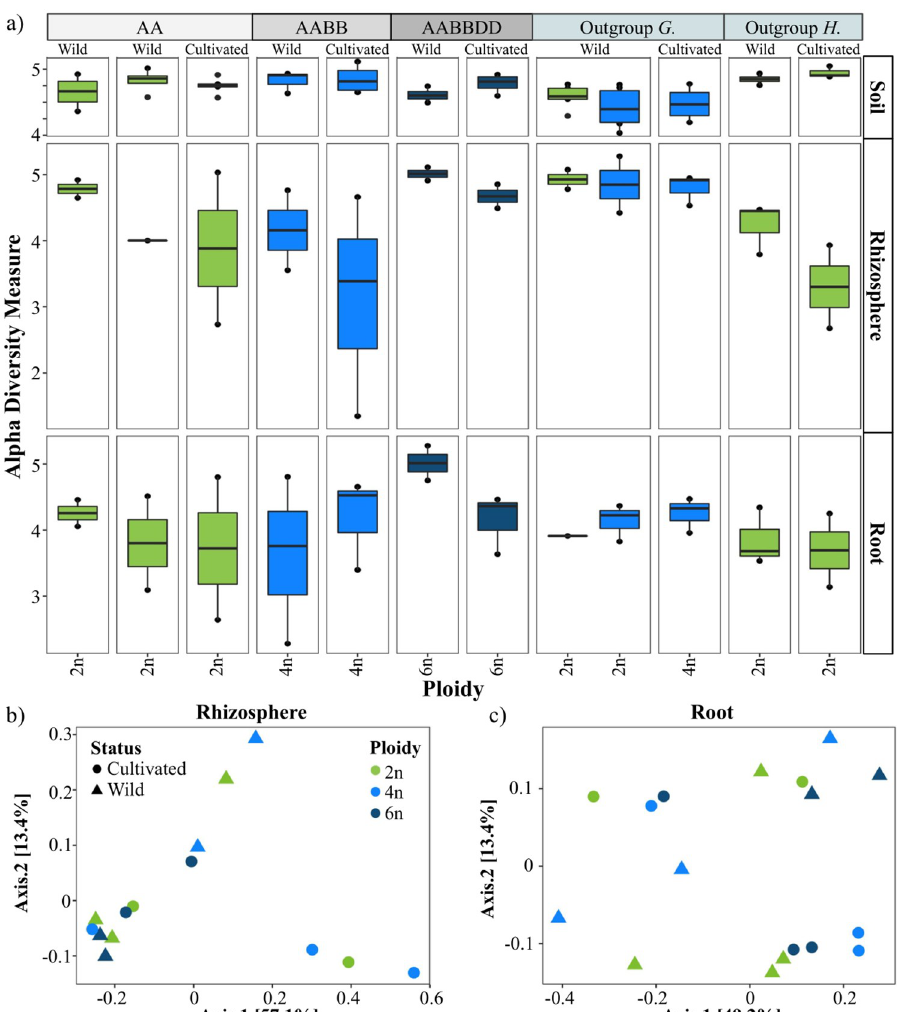
Fig 3. Alpha diversity shifts with ploidy level and domestication status. Alpha and beta diversity analyses of greenhouse study data, presented as boxplots of Shannon Diversity (a) and principal coordinates analyses using Bray- Cutis dissimilarity of wheat rhizosphere (b) and root (c) samples, with ploidy indicated by color (light green for 2n, blue for 4n, dark blue for 6n) and domestication status by shape in (b) and (c) (circle for cultivated and triangle for wild species). Genome lineage is denote by ‘AA’, ‘AABB’, and ‘AABBDD.’ Outgroup G . and H . denote genotypes in the genera Gossypium and Hordeum ,